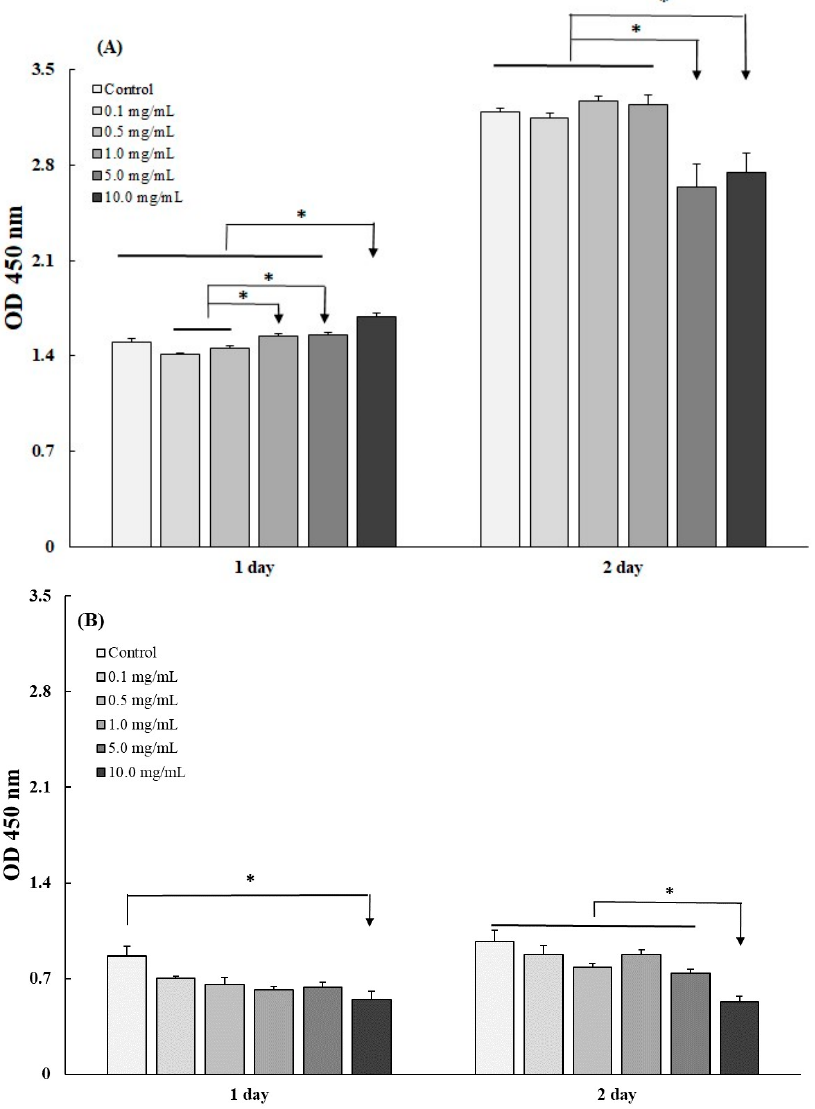
Figure 1. Cell proliferation based on the ratio of sericin to MSM by CCK-8 assay using L929 fibroblast. ( A ) Sericin and ( B ) MSM. All values are presented as the mean ± standard deviation (n = 3). * p < 0.05.